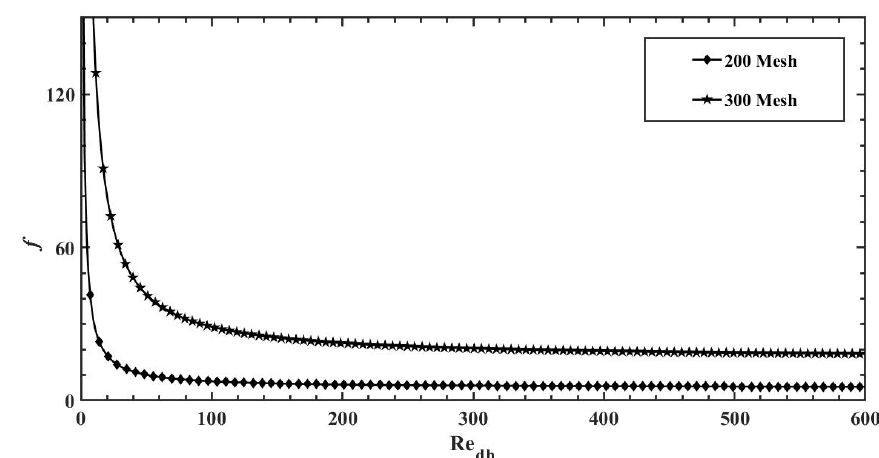
Figure 28. Friction factor calculated based on inertial and viscous Resistances.